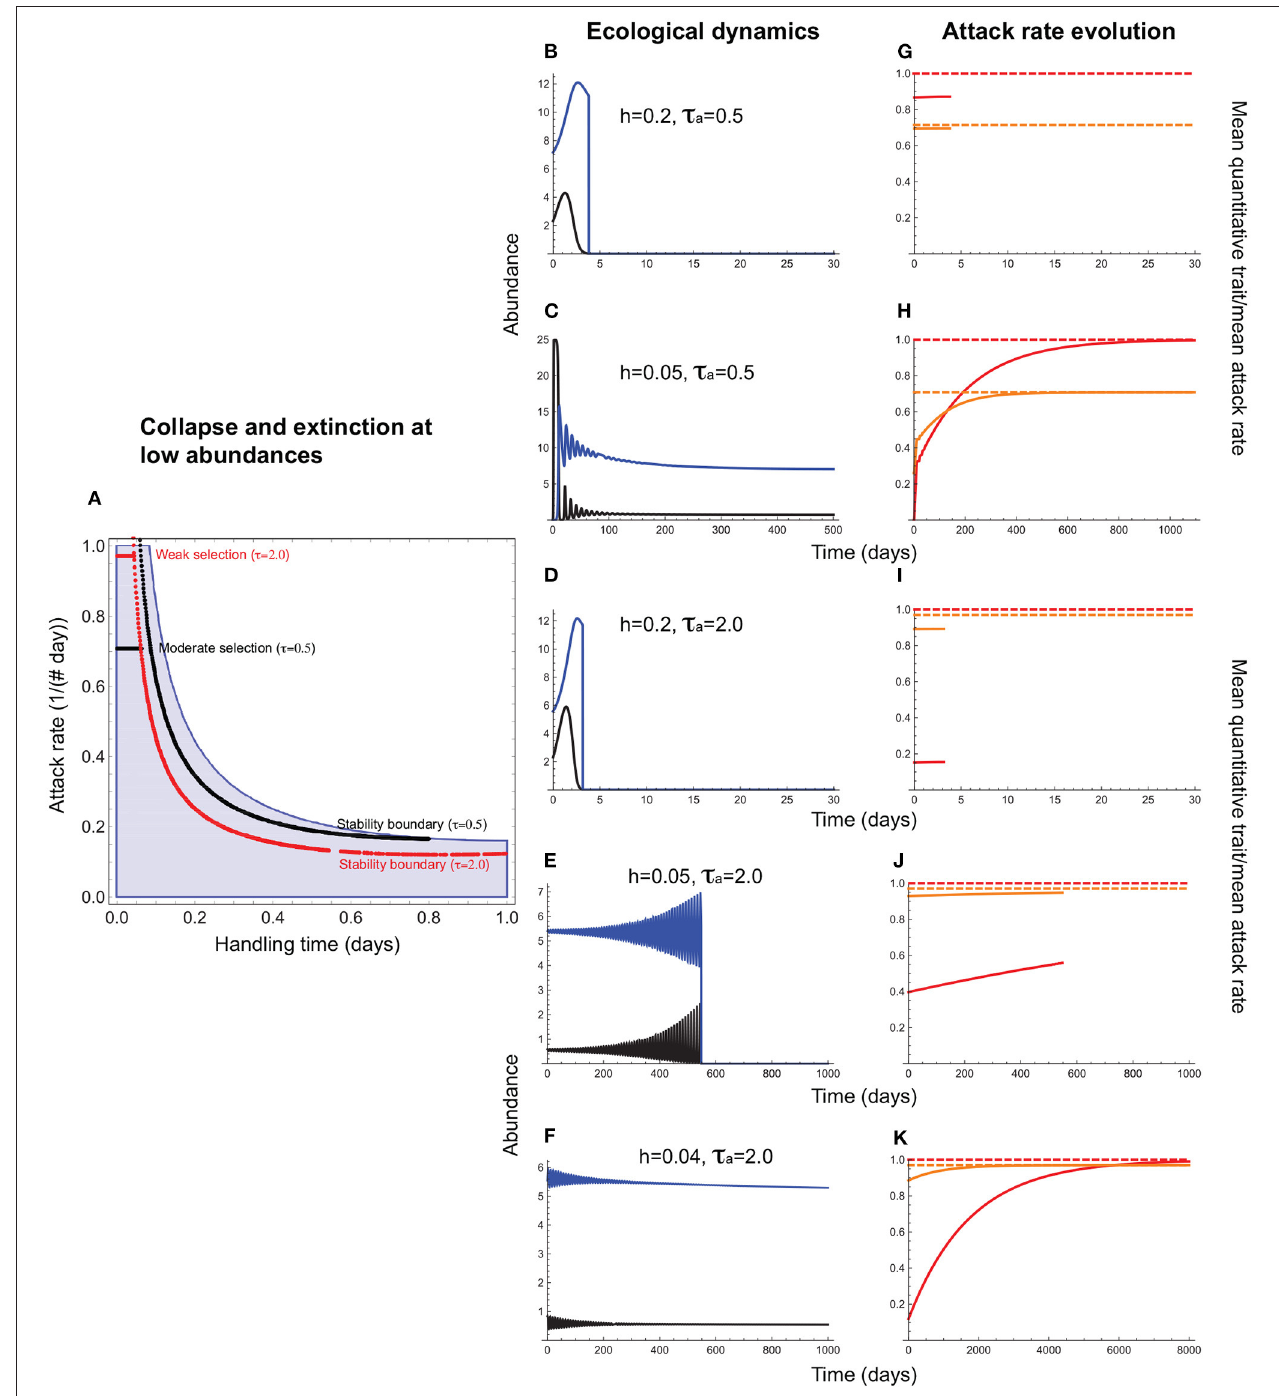
FIGURE 4 | Attack rate evolution (Equation 11) under interaction collapse and extinction at low abundances. In (A) , the red and black horizontal lines depict the attack rate-handling combinations that evolve in the model for varying strengths of stabilizing selection. Note that these lines terminate well before before the handling time reaches its maximum ( h 1.0) because when h is long, oscillations become sufficiently large to cause either extinction at low abundances (if there is sufficient = negative feedback to maintain bounded fluctuations) or collapse (if negative feedback is too weak to prevent divergent oscillations). (B–F) depict resource (black) and consumer (blue) abundances and (G–K) , the mean attack rate [ a ( x ), orange line] the corresponding quantitative trait mean ( x , red line), and the expected optima for ατ a a ( x ) ( a ( θ a ) ; orange dashed line) and x ( θ a ; red dashed line). (B,G,D,I) illustrate how the outcomes depicted in Figures 3C,G,E,I change when extinction √ σ a 2 = 2 + τ a b